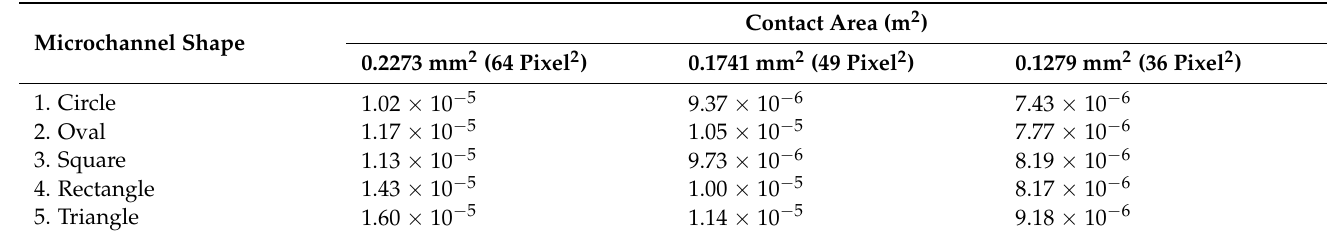
Table 9. Contact area of microchannels with variable shape and cross-sectional